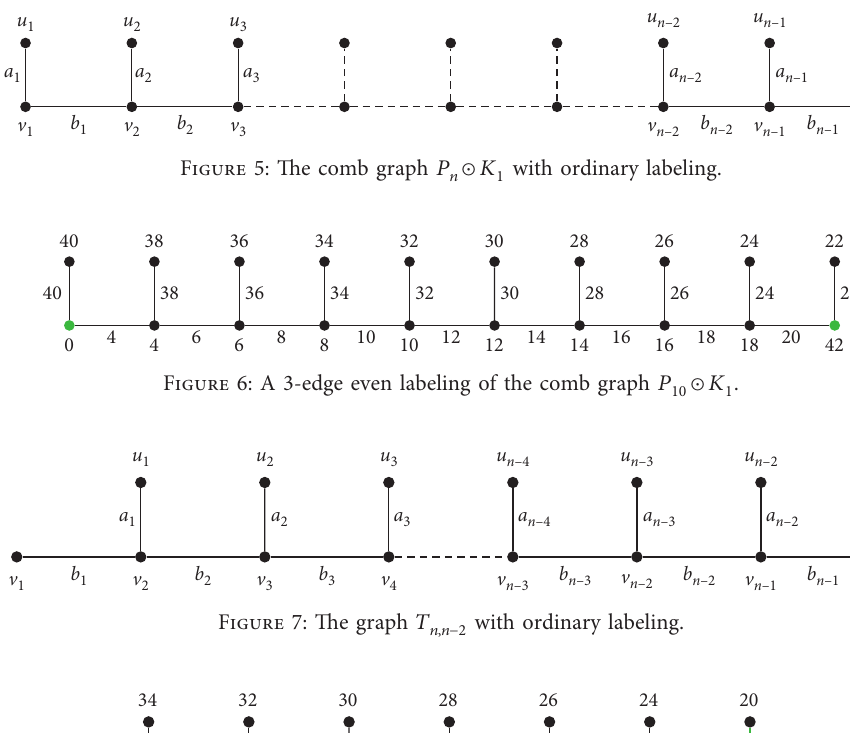
Figure 8: A 3-edge even labeling of the graph T